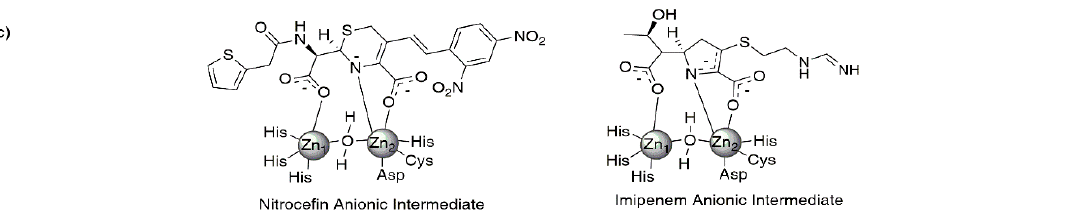
Figure 3. Reaction mechanism of serine- β -lactamases (SBLs) and MBLs. General reaction mechanisms for cephalosporin hydrolysis by ( a ) SBLs and ( b ) MBLs. ( c ) Reaction intermediates formed during nitrocefin and imipenem hydrolysis by MBLs. The following abbreviations were employed: Enzyme (E), Substrate (S), Tetrahedral Intermediate (TI), Covalent Intermediate (CI), Product (P), Enzyme:Substrate Complex (ES), High-Energy Tetrahedral Intermediate (HE-TI), Anionic Intermediate (AI), and Enzyme:Product Complex